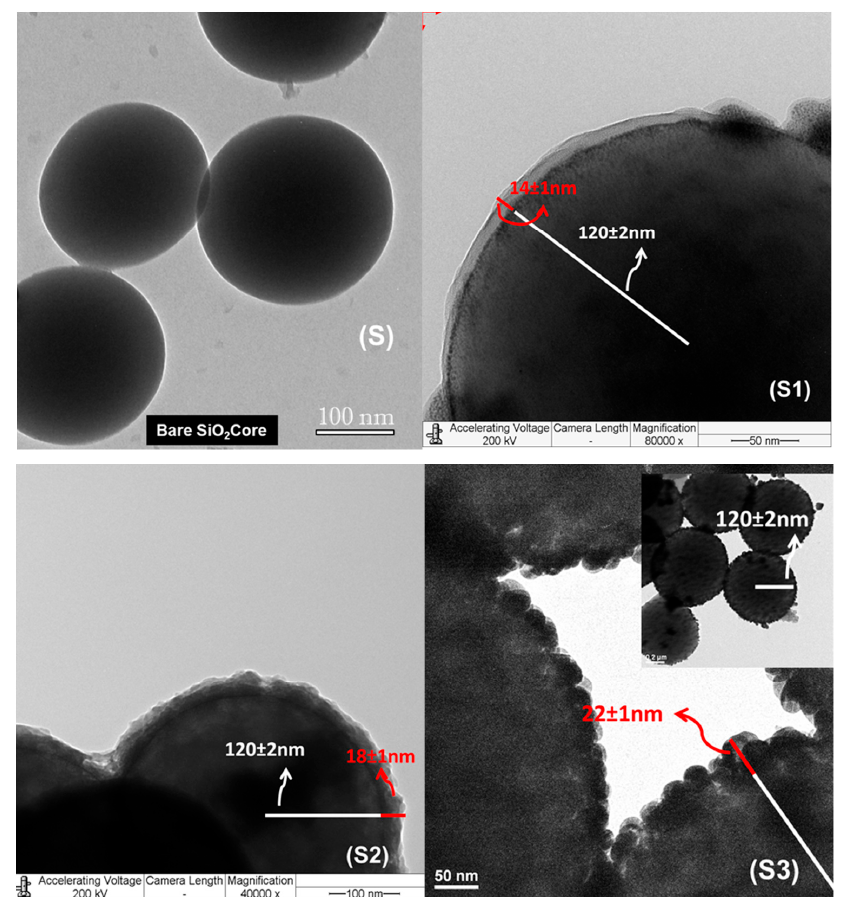
Figure 1. TEM images of the sample sets S, S1, S2, and S3. Sample S represents the bare SiO 2 nanoparticles. Higher magnification TEM images are given for sets S1, S2 and S3, which have shell thickness of approximately 14, 18, and 22 nm, respectively. The inset in the upper right corner of S3 shows a lower magnification TEM image of the same sample.